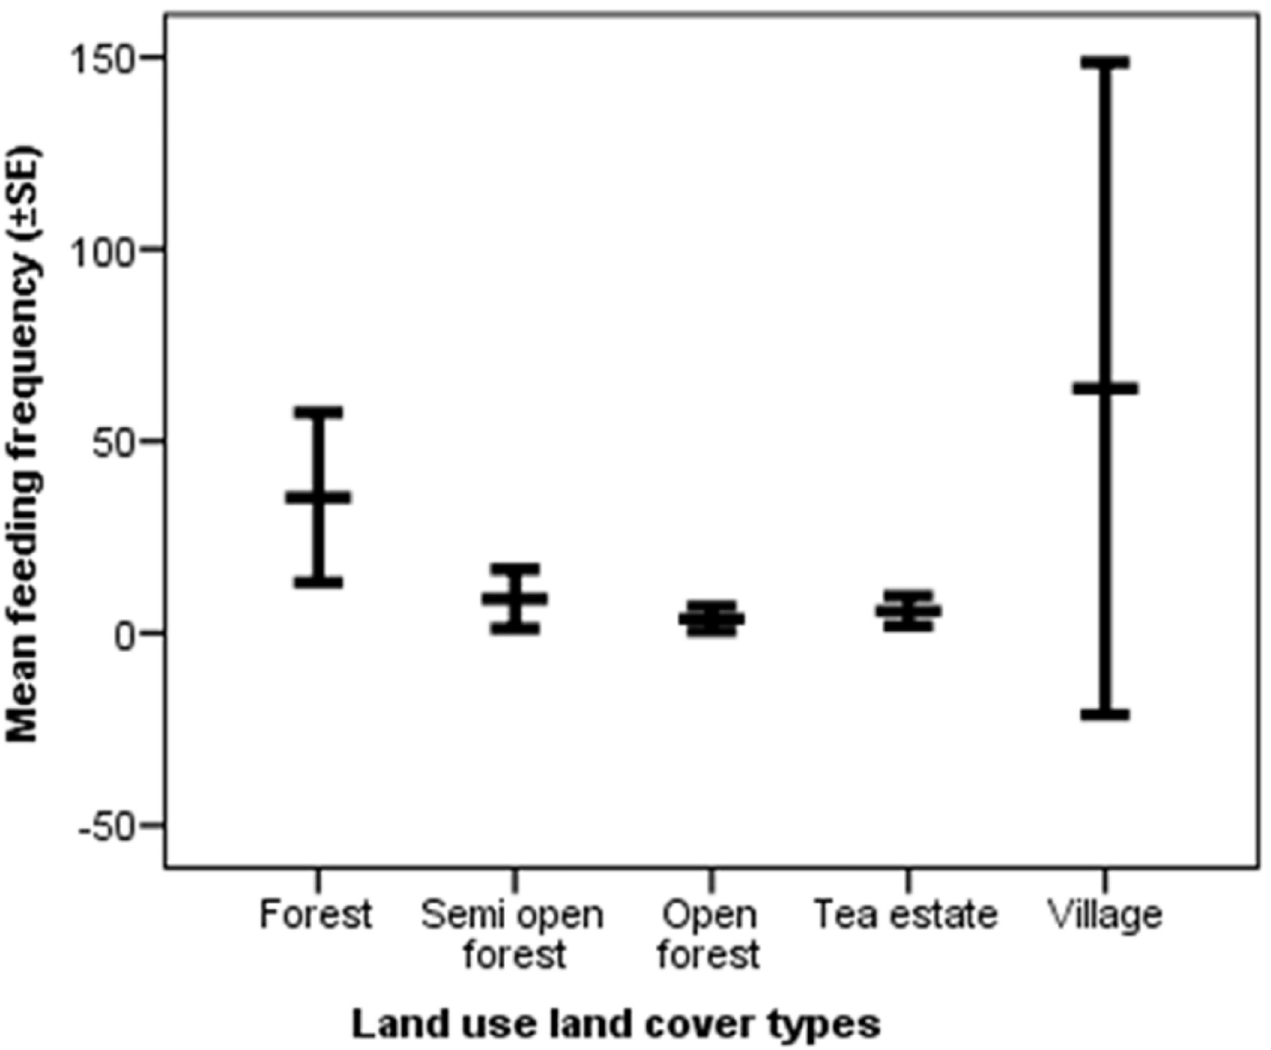
Fig 5. Mean feeding frequency of Asian elephant per trail in different land use and land cover